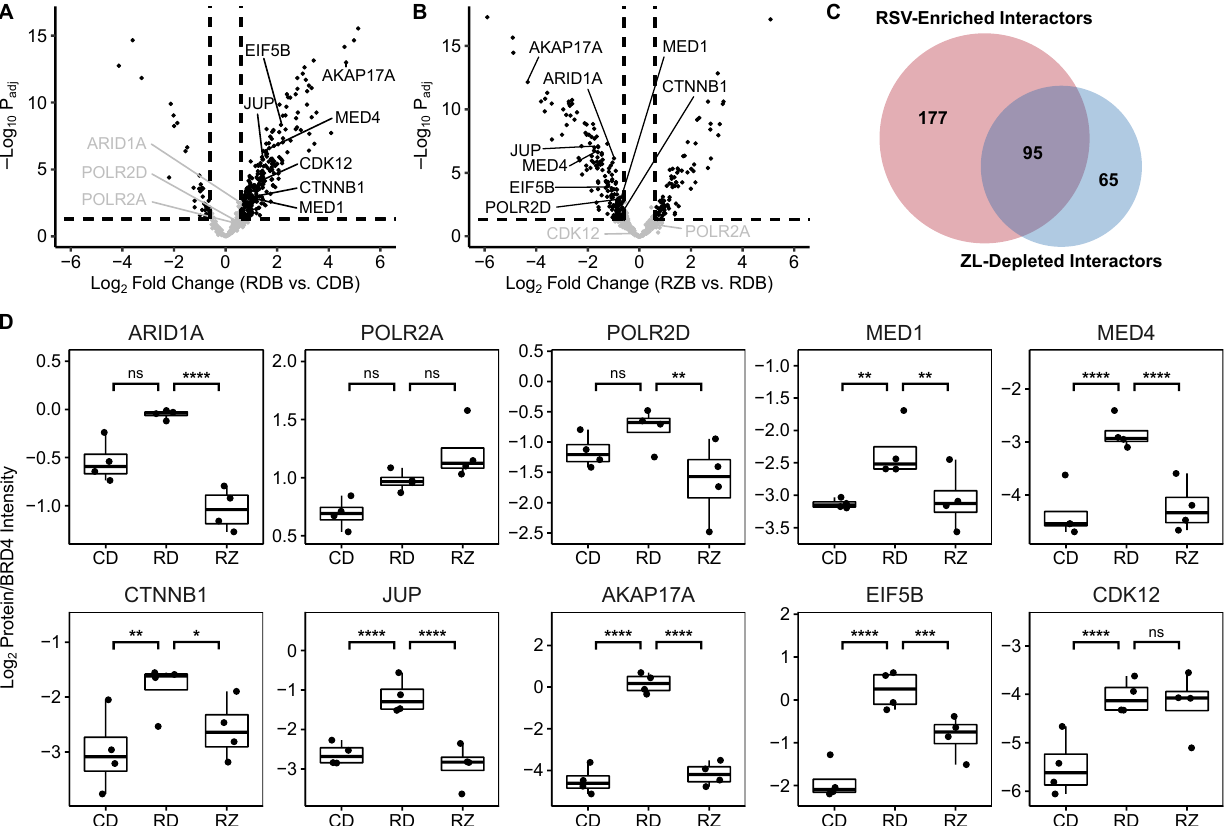
Figure 5. RSV-infection induces bromodomain-sensitive BRD4 interactions. ( A ) Volcano plot demonstrating fold change enrichment of BRD4 interactors induced by RSV-infection. ( B ) Volcano plot demonstrating fold change alterations to the RSV-stimulated BRD4 complex when treated with ZL0454. ( C ) Venn diagram illustrates overlap between RSV-enriched interactions and ZL0454-depleted interactions. ( D ) Boxplots demonstrate relative abundance of notable proteins in the BRD4 complex. Boxplots represent n = 4 biological replicates per experimental group. Each data point represents the mean of n = 2 technical replicates. * P adj < 0.05; ** P adj < 0.01; *** P adj < 0.001; **** P adj < 0.0001